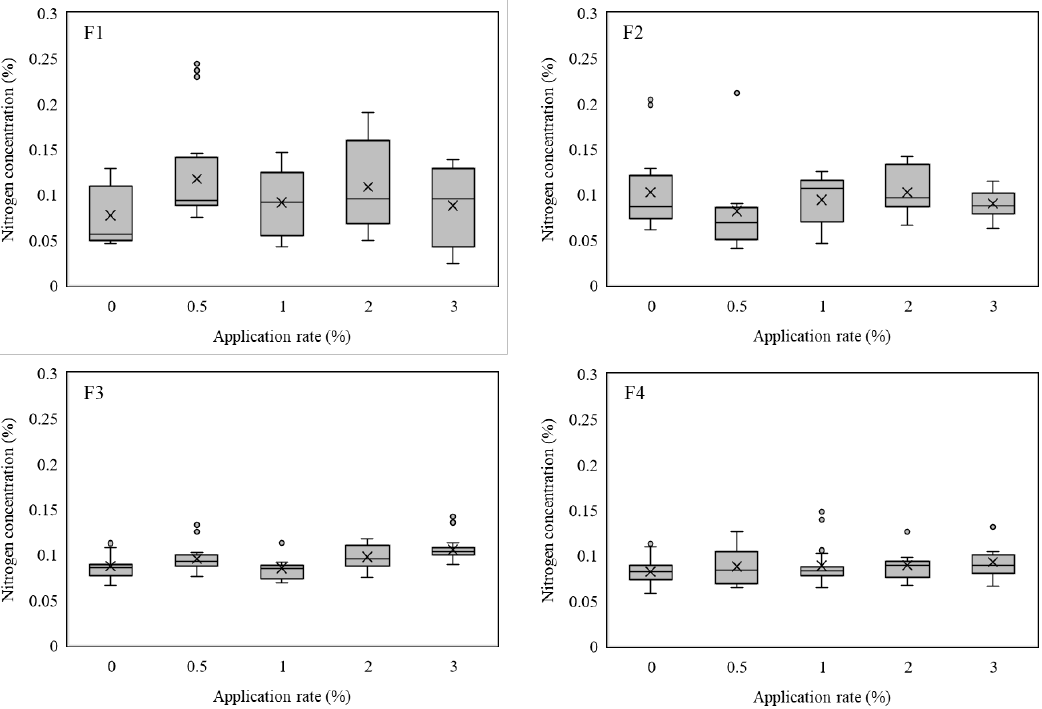
Figure 2. Box plot graph showing the soil nitrogen content with different application rate in F1, F2, F3, and F4. (F1: CBB ash A and pig manure; F2: CBB ash A; F3: CBB ash B and pig manure; F4: CBB ash B)